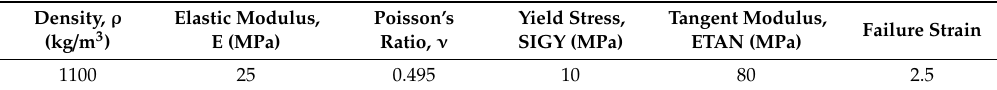
Table 3. Parameters for TPU.